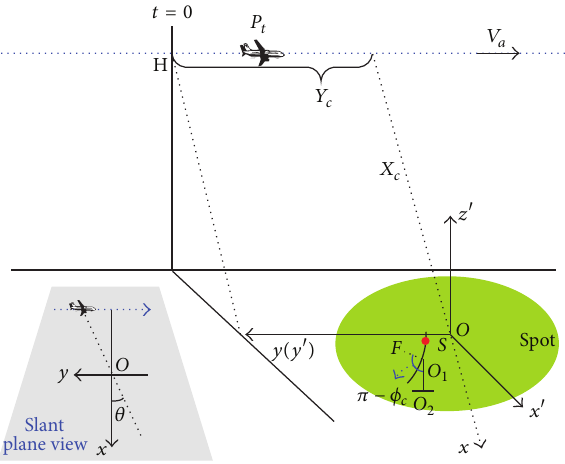
Figure 2: SAR geometry with a